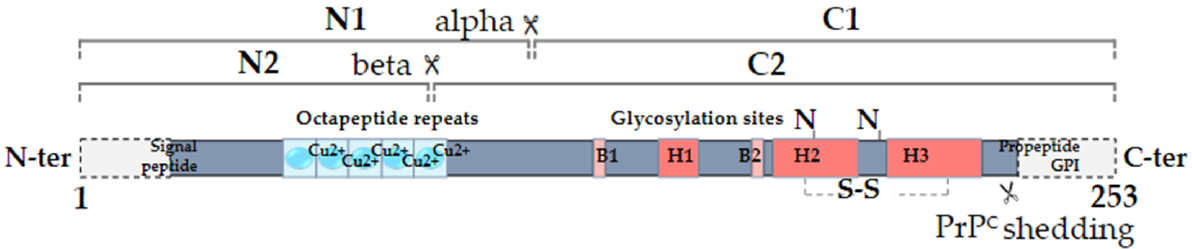
Figure 1. Secondary structure of human PrP C . The alpha-cleavage occurs at position 110/111 and generates the N1 and C1 fragments. The beta-cleavage occurs in the vicinity of octapeptide repeats, which bind copper ions, and generates the N2 and C2 fragments. PrP C can also be shed from the plasma membrane through the action of ADAM10. The alpha helices (H) and beta sheets (B) are indicated (adapted from [7]).